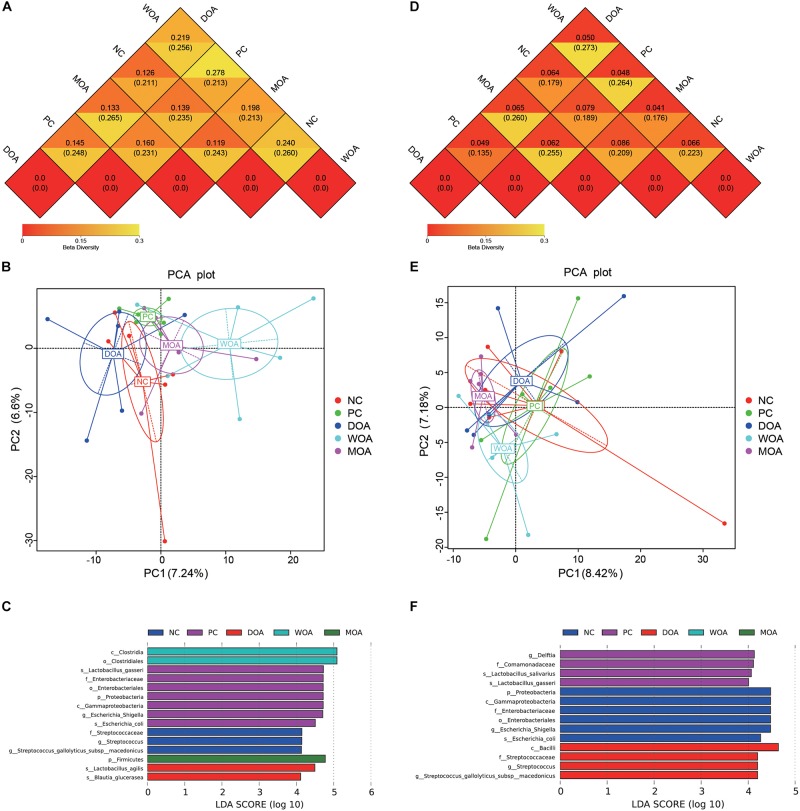
Beta-diversity of microbiome residing in the cecal chyme of broilers at the ages of 21 and 42 days. (A) Beta-diversity heatmap at 21 days. (B) PCA plot at 21 days. (C) LDA distribution histogram at 21 days. (D) Beta-diversity heatmap at 42 days. (E) PCA plot at 42 days. (F) LDA distribution histogram at 42 days. Values are expressed as the means. NC, negative control, basal diet and basal drinking water with no antibiotic supplementation; PC, positive control, antibiotics supplementation; DOA, NC plus diet-administered OA supplementation; WOA, NC plus water-administered OA supplementation; MOA, NC plus diet-administered and water-administered OA supplementation. p, phylum; c, class; o, order; f, family; g, genus; s, species. In the beta-diversity heatmap, the two values in the same grid represent the distance of the weighted UniFrac distance and the unweighted UniFrac distance, and the number in the grid is the difference coefficient between two groups; the smaller the difference coefficient is, the smaller the difference in species diversity is. In PCA plots, axes represent the two dimensions explaining the greatest proportion of variances in the communities for each analysis; if the community composition of groups is more similar, the distance between them in PCA diagram is closer. The LDA value distribution histogram shows the species whose LDA score is greater than the set value (the default setting is 4), that is, the biomarker with a significant difference between the groups. The length of the histogram represents the influence of different species (LDA score).